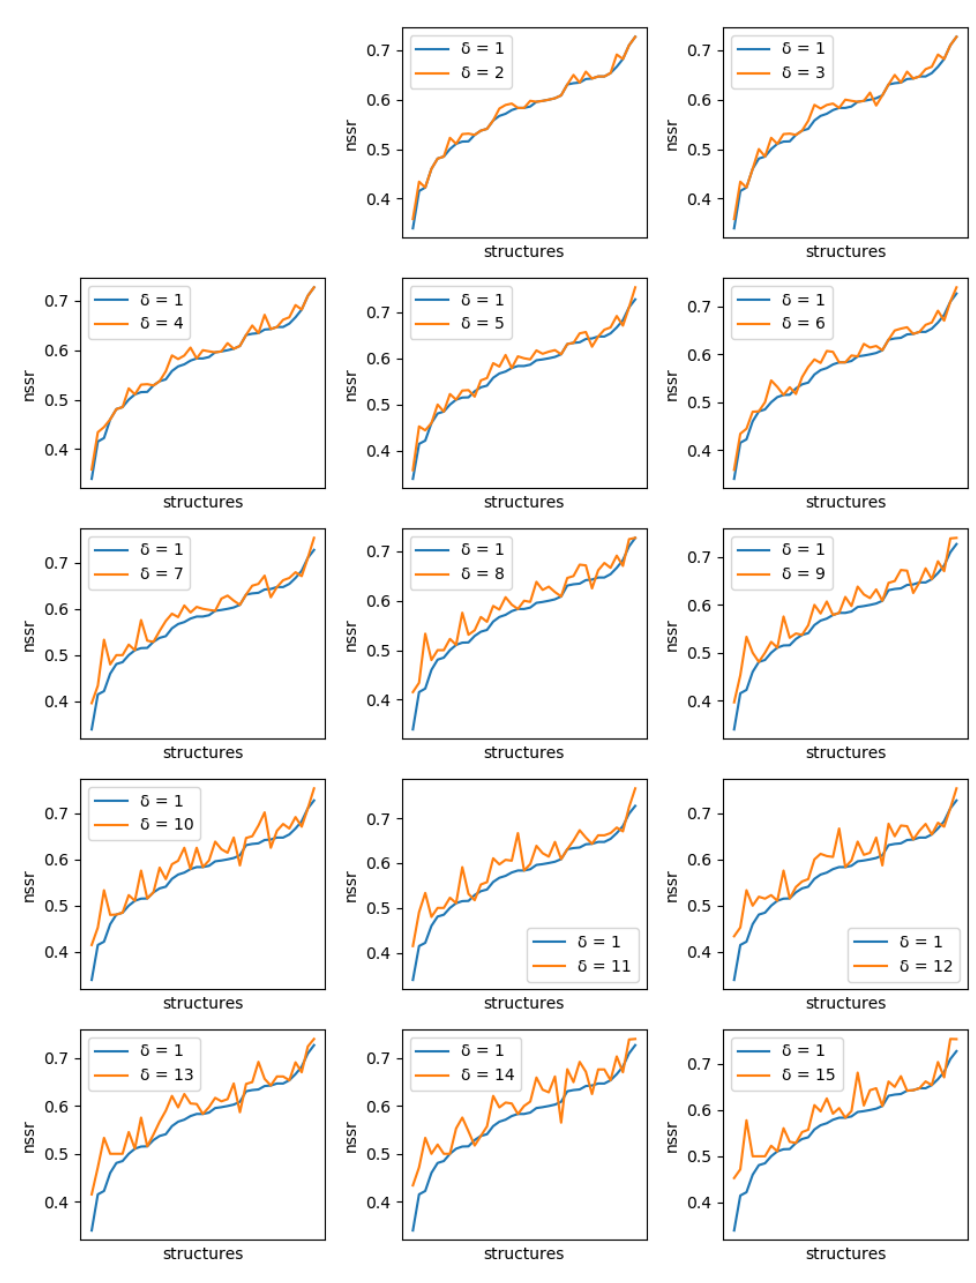
Figure 7. Comparison of the best NSSR value obtained with ten 1-diverse sequences ( δ = 1, blue curve) with the best NSSR value obtained with libraries of ten sequences of increased diversity. Each plot corresponds to a specific additional value of δ ( δ = 2 to 15, golden curve). Plots are ordered lexicographically from top-left to bottom-right, with increasing values of diversity ( δ ). In each plot, the X-axis ranges over all tested backbones, sorted in increasing order of NSSR value for the 1-diverse case and the Y-axis gives the corresponding NSSR value. As the diversity requirement δ increases, the NSSR value indicated by the golden curve increases also